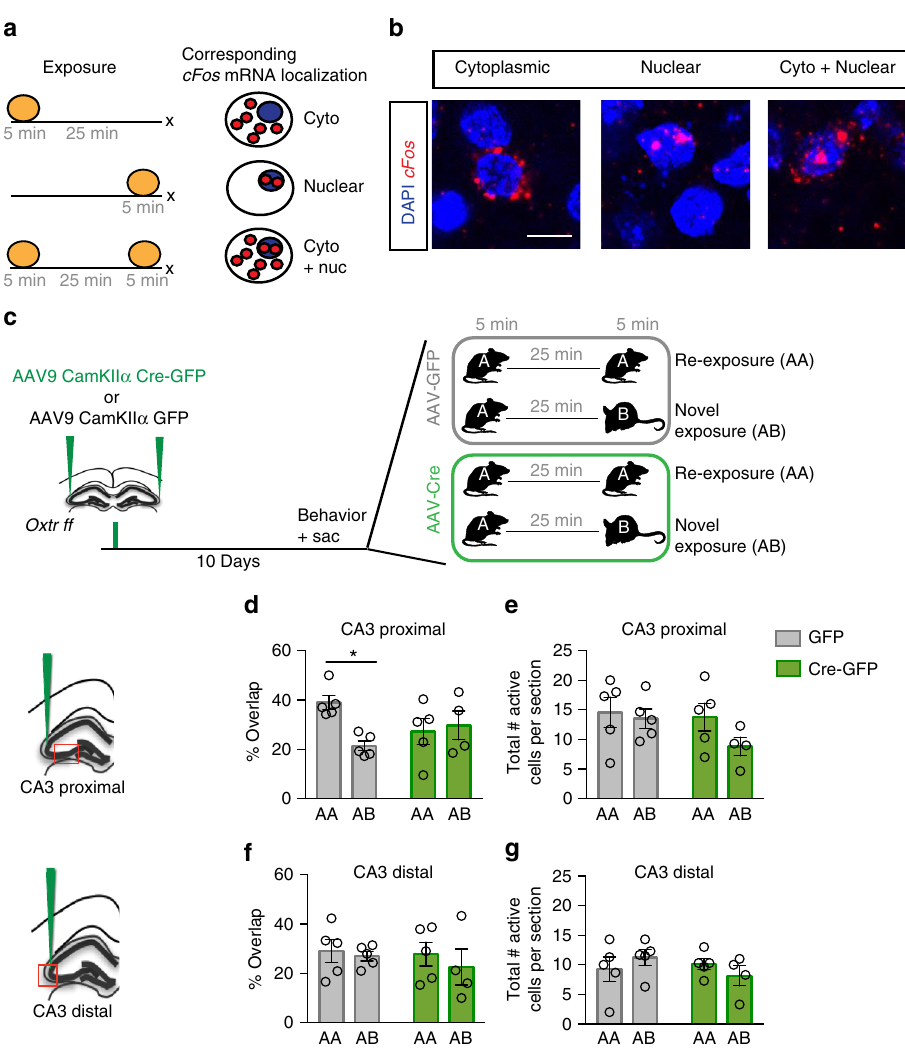
Fig. 4 Viral recombination of Oxtr in aCA2/CA3 distal impairs population based coding of social stimuli. a Schematic illustrating conceptual design of catFISH using c - fos intronic and full-length mRNA localization as readouts for ensembles of neurons activated at distinct behavioral windows. b Representative images of CA3 pyramidal neurons exhibiting cytoplasmic, nuclear, or cytoplasmic and nuclear localization of c-fos mRNA transcripts. Scale bar, 10 μ m. c Schematic illustrating viral injection and behavioral exposure timelines (GFP AA: n = 5, GFP AB: n = 5, Cre AA: n = 5, Cre AB: n = 4). d , f Percent overlap between ensembles of neurons encoding fi rst and second stimulus for CA3 proximal (top) and CA3 distal (bottom), respectively. e , g Total number of active cells per section for CA3 proximal (top) and CA3 distal (bottom), respectively. All data are displayed as mean ±